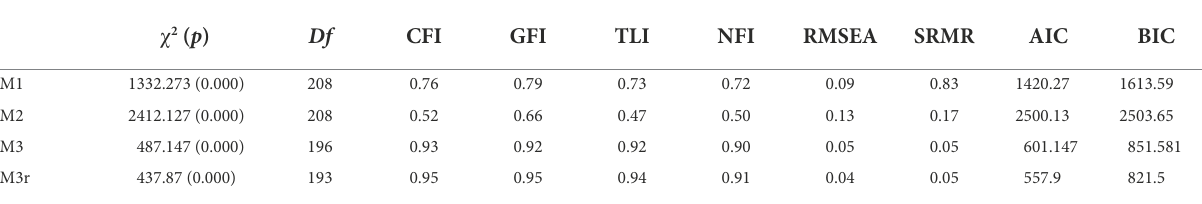
TABLE 2 Fit indices for each specified model of the SWING scale in Argentine